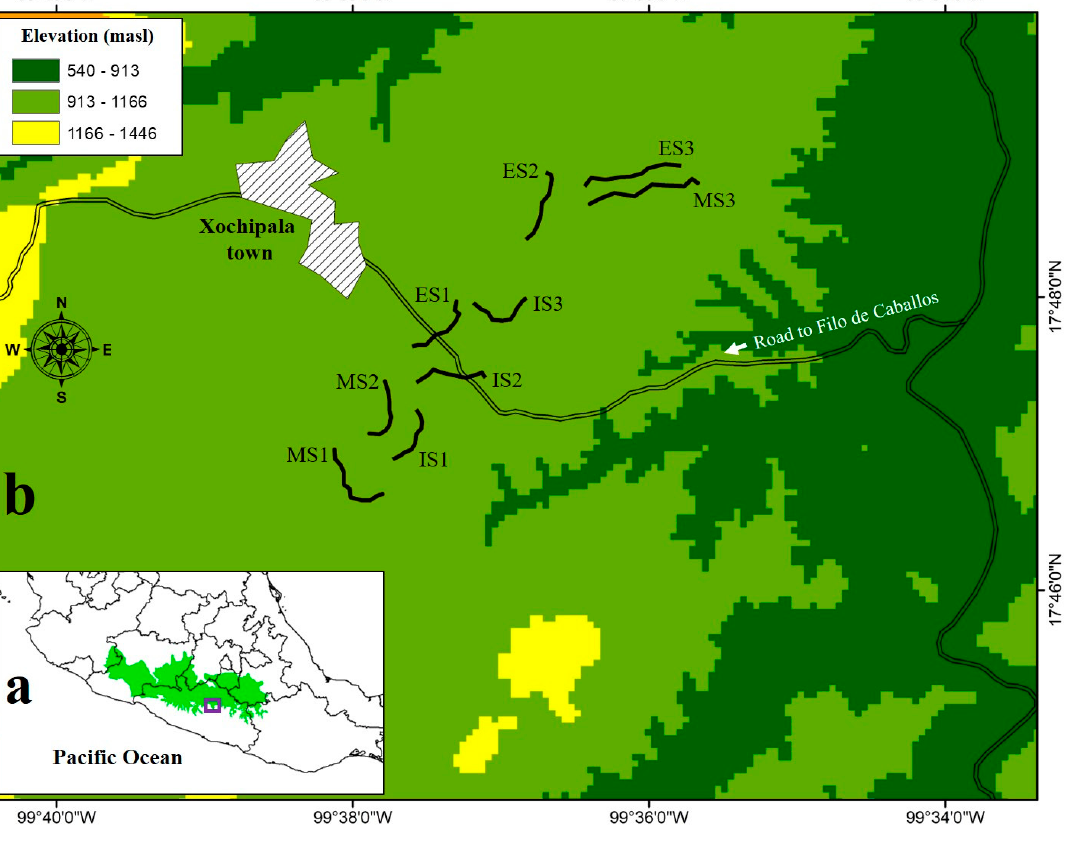
Figure 1. Geographical location of the study area in the Balsas basin, southern Mexico ( a ) and the sampling transects ( b ). The numbers (1–3) represent the three sites of each successional stage: early stages (ES), intermediate stages (IS), and mature stages (MS).